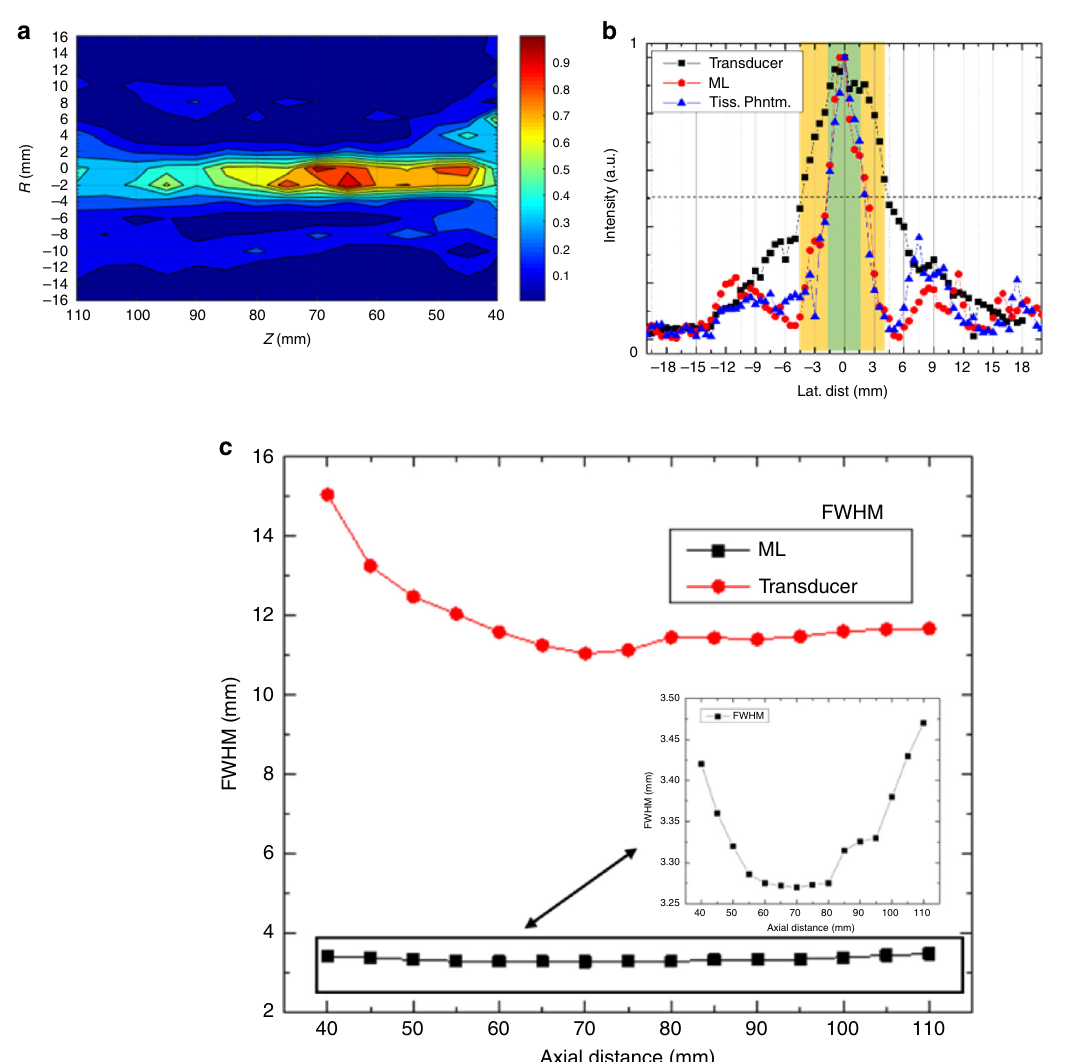
Fig. 3 Illustration of collimation behavior of the ML. Collimation-like spatial sound fi eld of ML at 576 kHz ( a ) and lateral beam width of the emitting transducer compared to the lens in a gelatin tissue phantom ( b ). The tissue phantom does not cause beam divergence and the beam remains collected along the optical axis. Whereas FWHM of the beam varies by 36% for the transducer, it only varies 4.5% for the length of the beam for the ML ( c